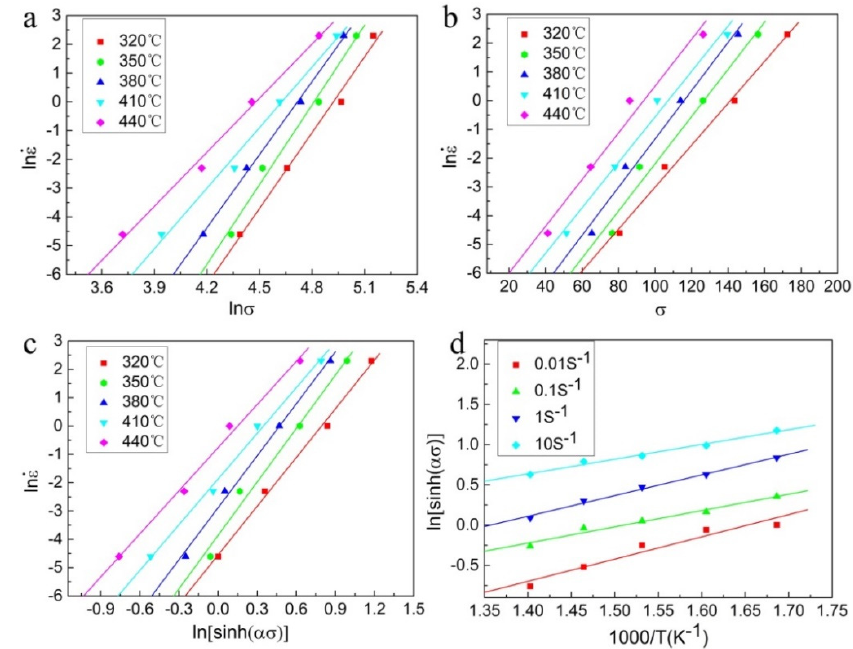
. ε . ε . ε –ln σ , ( b ) ln – σ , ( c ) ln – ln[sinh( ασ )], ( d ) ln[sinh( ασ )]–